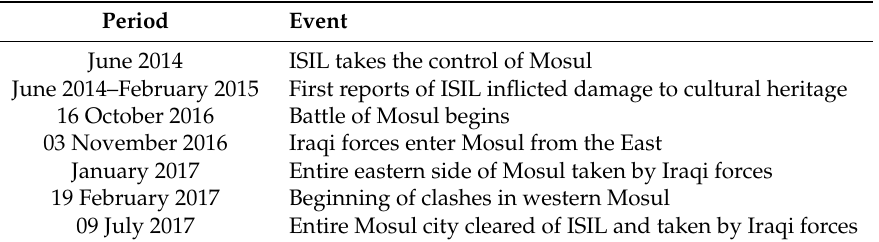
Table 1. Main event during the period 2013–2018 related to the city of